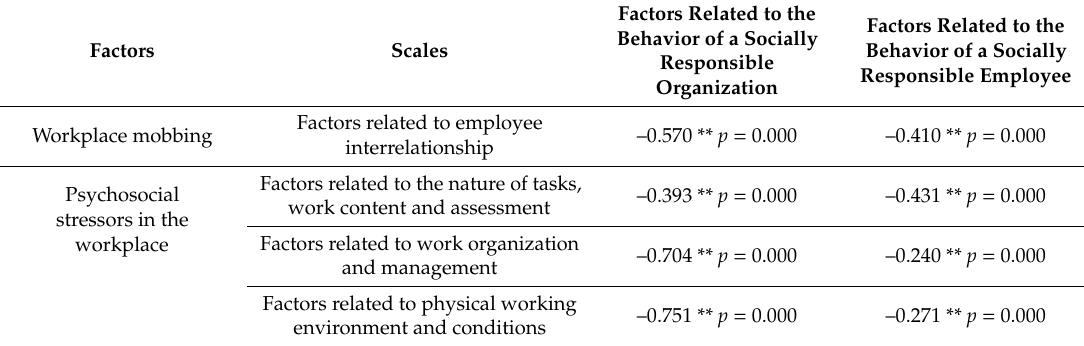
Table 3. Correlation relationships between workplace mobbing, psychosocial stressors and corporate social responsibility scales in the joint sample of organizations of both countries ( N min = 823; N max =